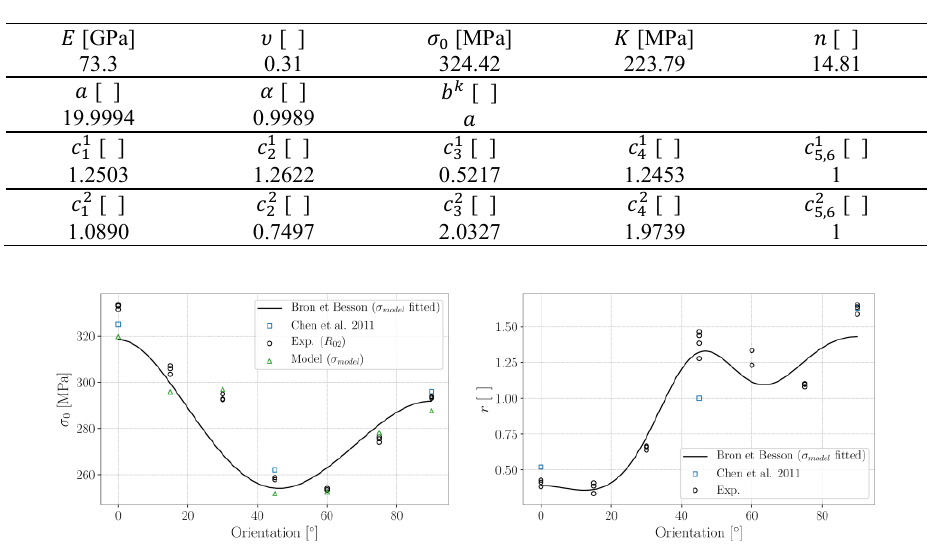
Fig. 1. Angular variation of the initial yield stress (left) and of the Lankford coefficient (right)